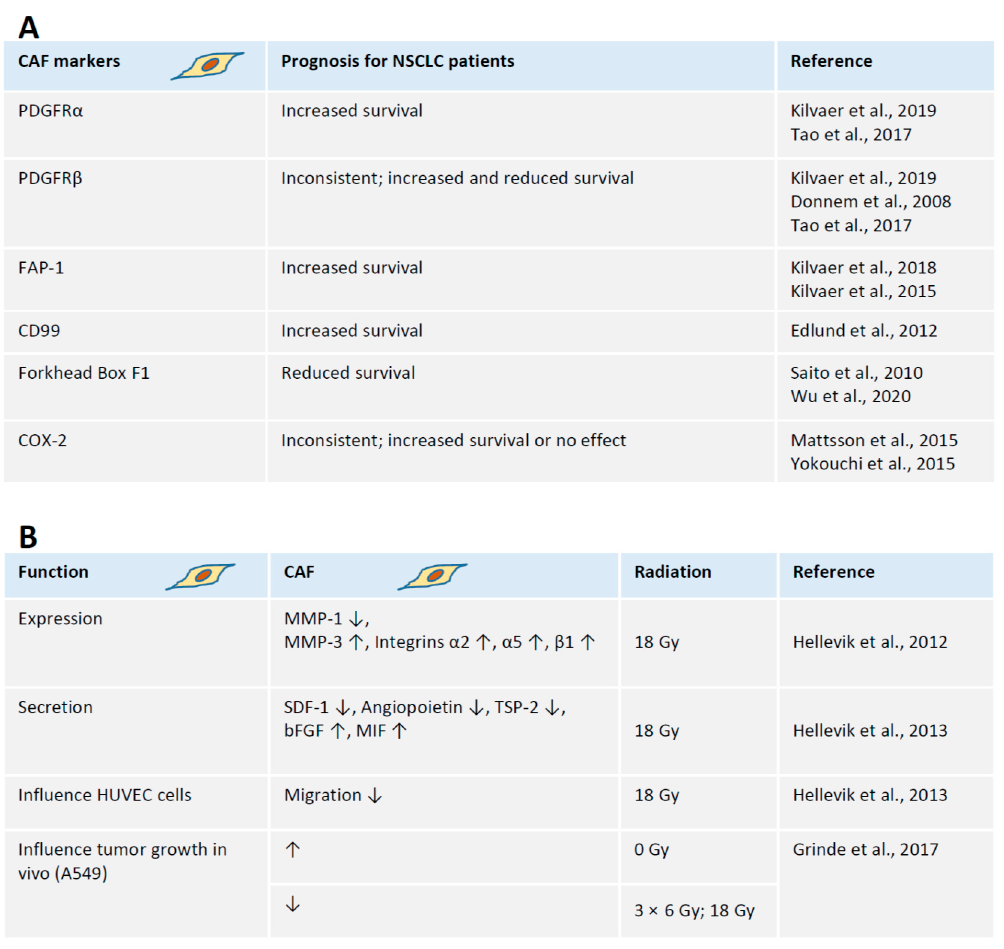
Figure 1. CAFs as a component of tumor stroma. ( A ) Radiation influences CAF physiology and function. ( B ) The prognosis for NSCLC patients based on the CAF biomarkers. References to